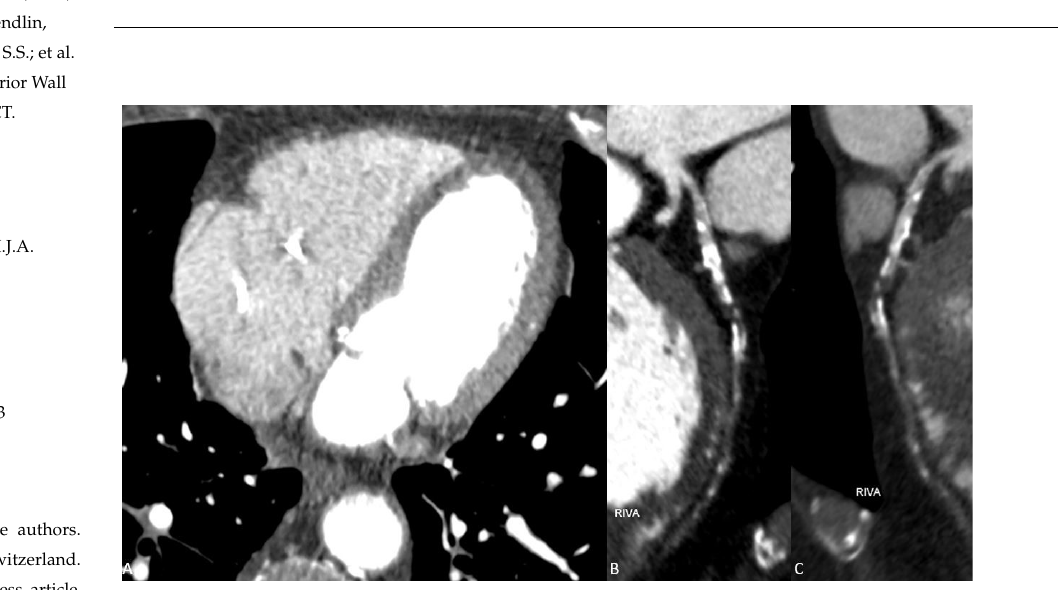
Figure 1. Conventional arterial paratransversal CT series ( A ) and reconstructions ( B , C ) show mul- tiple soft and calcified plaques in the LAD (RIVA) in the context of CAD. However, the presence